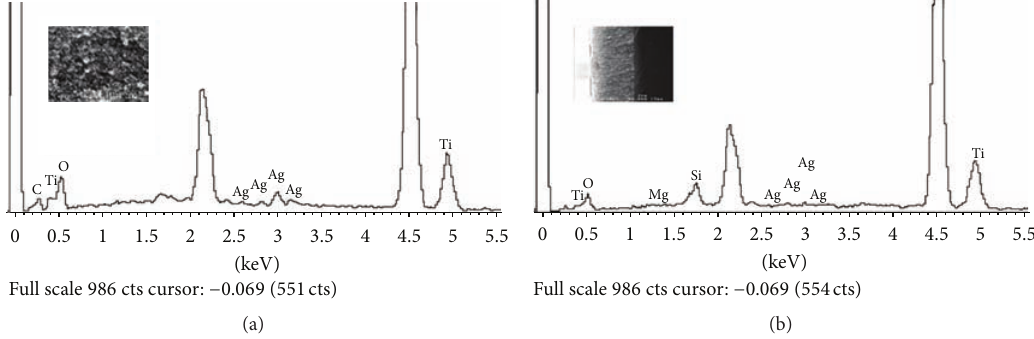
Figure 5: EDX spectra taken from (a) surface and (b) cross section of TiO 2 /MgO (0.10 nm)/Ag (4.4nm) composite